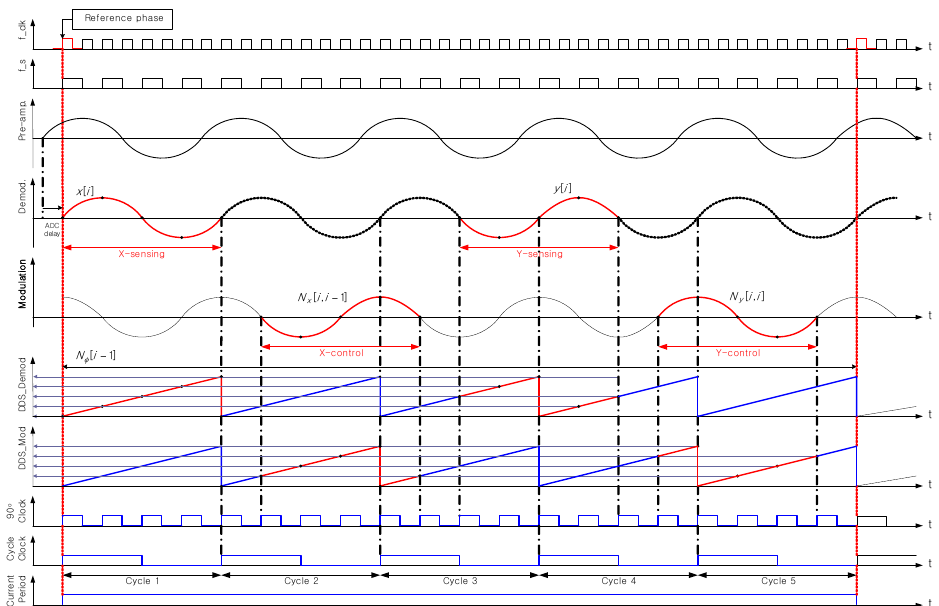
Figure 8. HRG sensing and control signal time diagram.